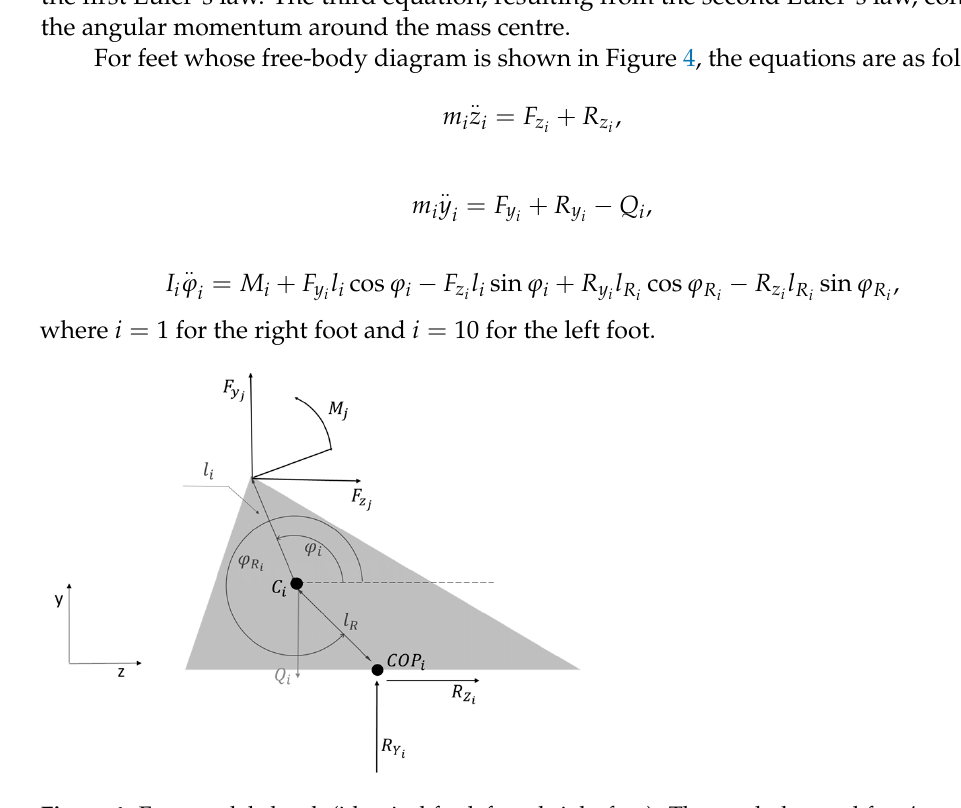
Figure 4. Foot model sketch (identical for left and right foot). The symbols stand for: i —segment number, which takes the value of 1 or 11 (according to Figure 3), l i —the distance between the centre of mass of the foot ( C i ) and the ankle joint, l R ¯ the distance between the centre C i and the centre of i pressure COP , ϕ R —the directed angle that defines the location of the segment joining the centres of i mass and pressure, and R y , R z —components of the reaction i i